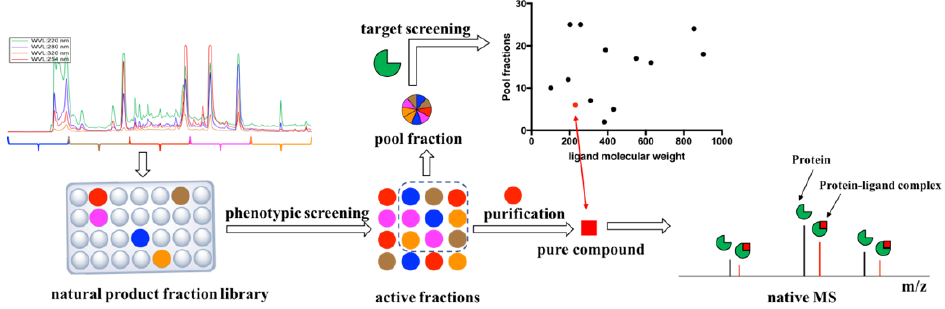
Figure 1. Overview of natural product drug discovery using both phenotypic screening and target screening approaches. A high throughput phenotypic screening of 202,983 Nature Bank (NB) lead- like enhanced (LLE) fractions [20] against M. tuberculosis H 37 Rv was initially performed. Active fractions were screened against a panel of 37 putative anti-tuberculosis (TB) targets from Mycobacteria species. To lower sample consumption, especially protein, nine active fractions were pooled (40 Pool Fractions) and incubated with each of the target proteins. The pooled fraction–protein mixtures were examined by native mass spectrometry to identify protein–ligand complexes. The mass shift between the protein (black) and the protein–ligand complex (red) peaks provided the molecular weight of the bound ligand.